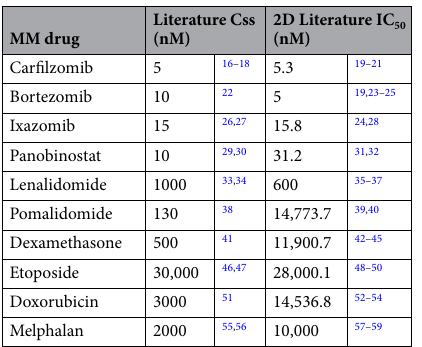
Table 1. Names, concentrations, and literature for each of the drugs